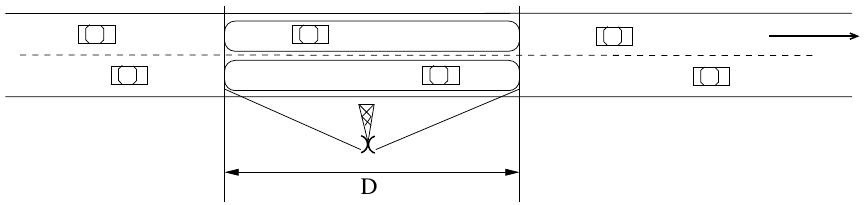
Figure 2. Illustrating the coverage area of a TMU [85]